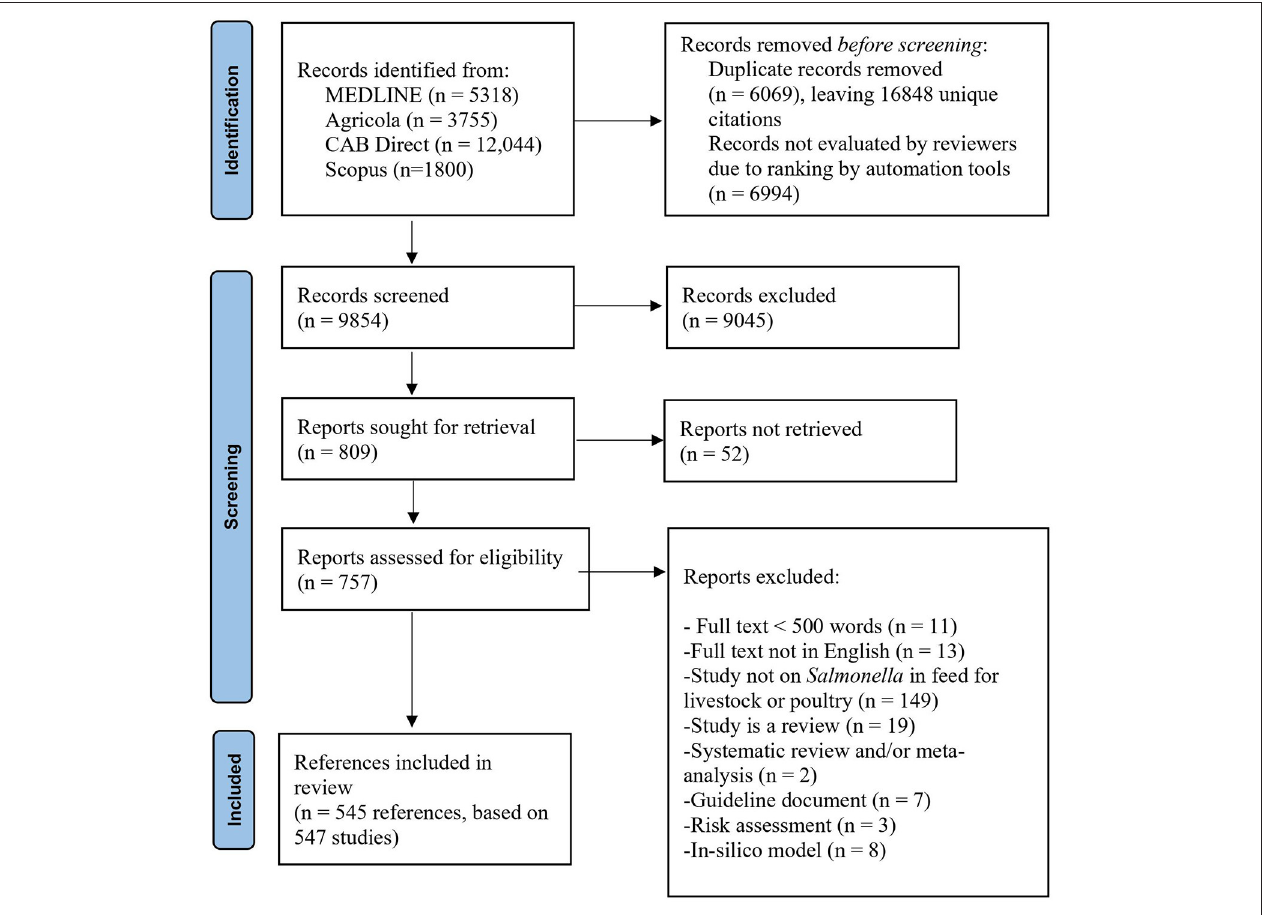
FIGURE 1 | PRISMA 2020 flowchart showing the flow of citations and abstracts in a scoping review of Salmonella in animal feeds modified from